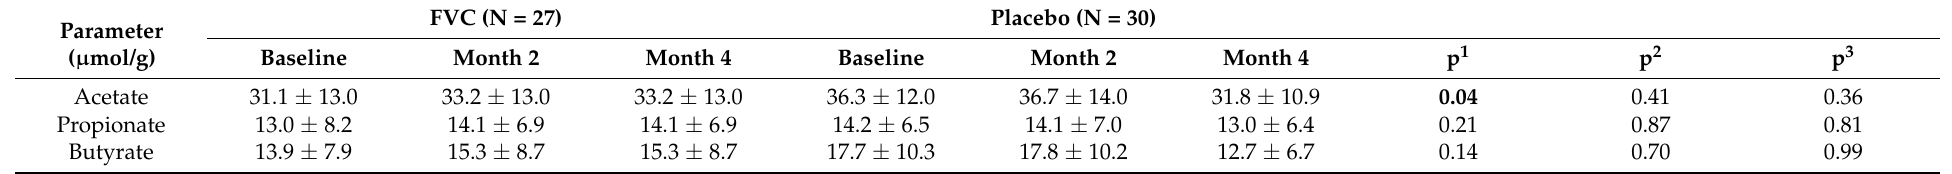
Table 6. Fecal short chain fatty acid levels for FVC vs. Placebo.